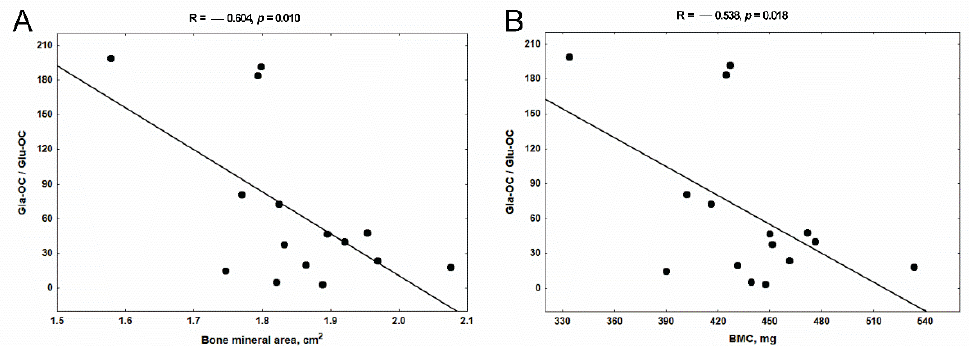
Figure 8. The associations between Gla ‐ OC/Glu ‐ OC ratio in trabecular bone tissue and the parameters of mineral status: bone mineral area ( A ) and BMC ( B ) of femoral bone of rats with chronic kidney disease (CKD). Gla-OC—carboxylated osteocalcin; Glu-OC—undercarboxylated osteocalcin; BMC—bone mineral content.